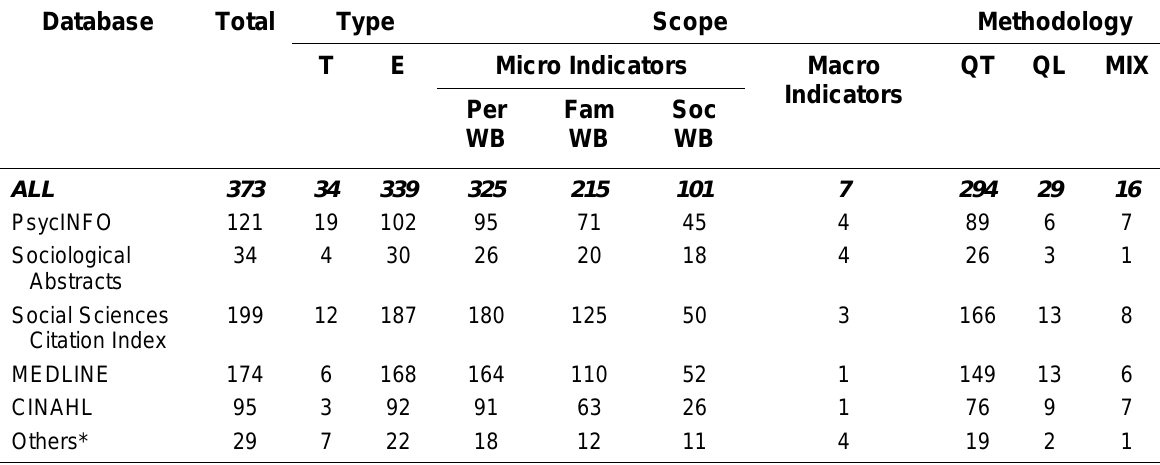
Classification of Studies about the QOL in Hong Kong in Three Dimensions (Type, Scope, and